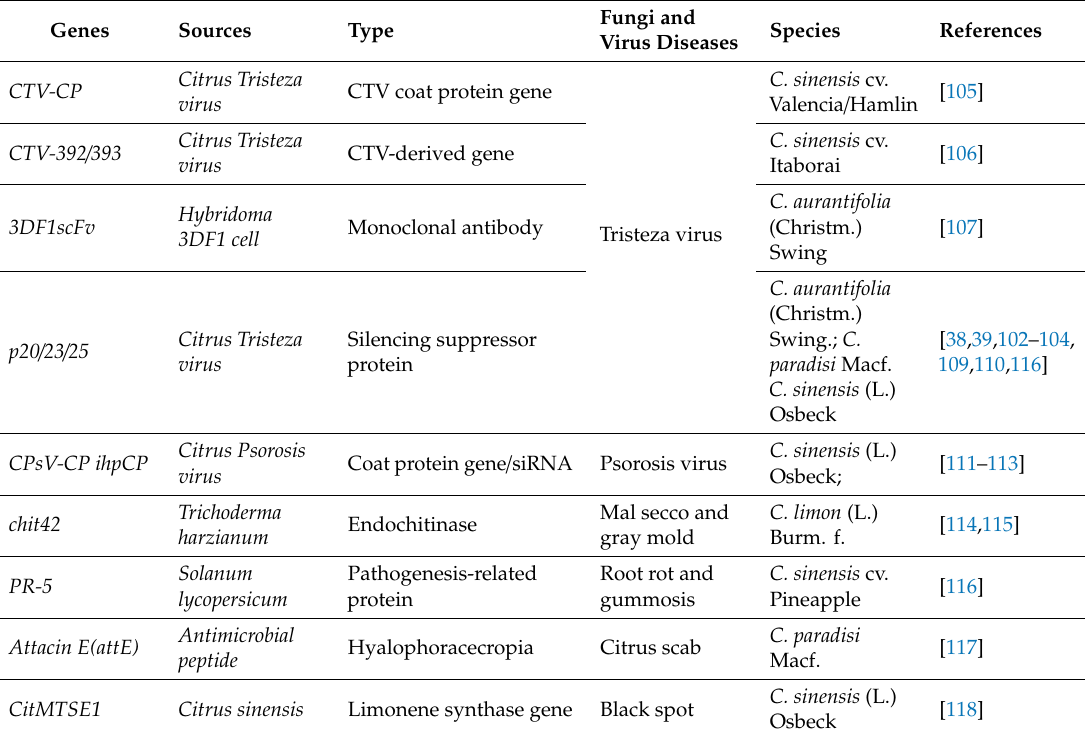
Table 2. The genes used for imparting resistance to fungal and viral diseases in